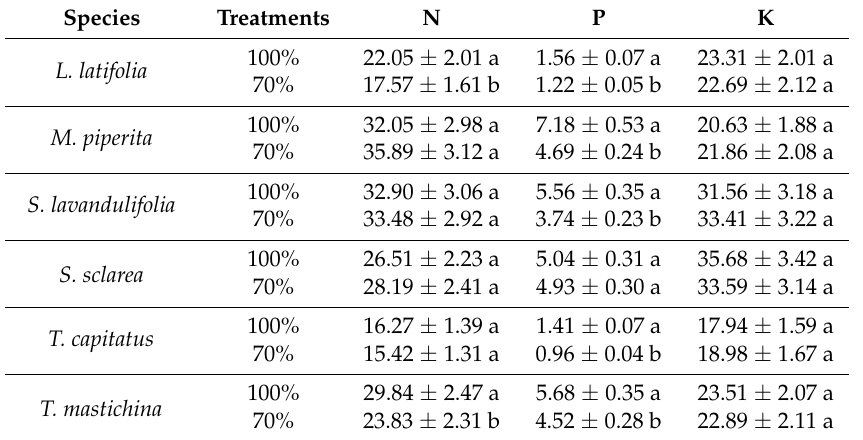
Table 5. Leaf nutrient concentration in the species studied under different drought conditions.